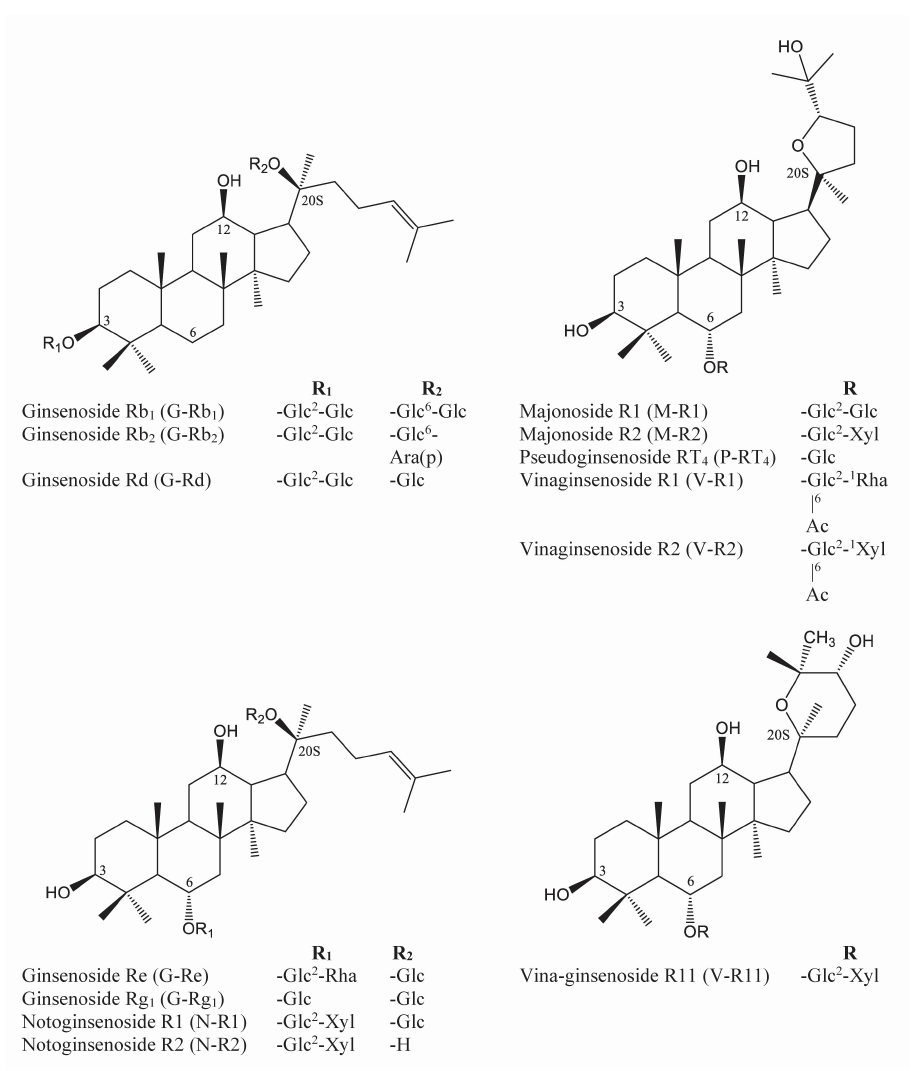
Figure 1. Structures of VG characteristic